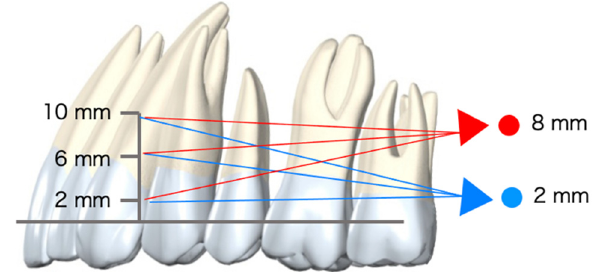
Figure 2. Six combinations with three retraction hook lengths (2 mm, 6 mm, and 10 mm) and two posterior anchor positions (2 mm and 8 mm from the maxillary first molar cervical region).